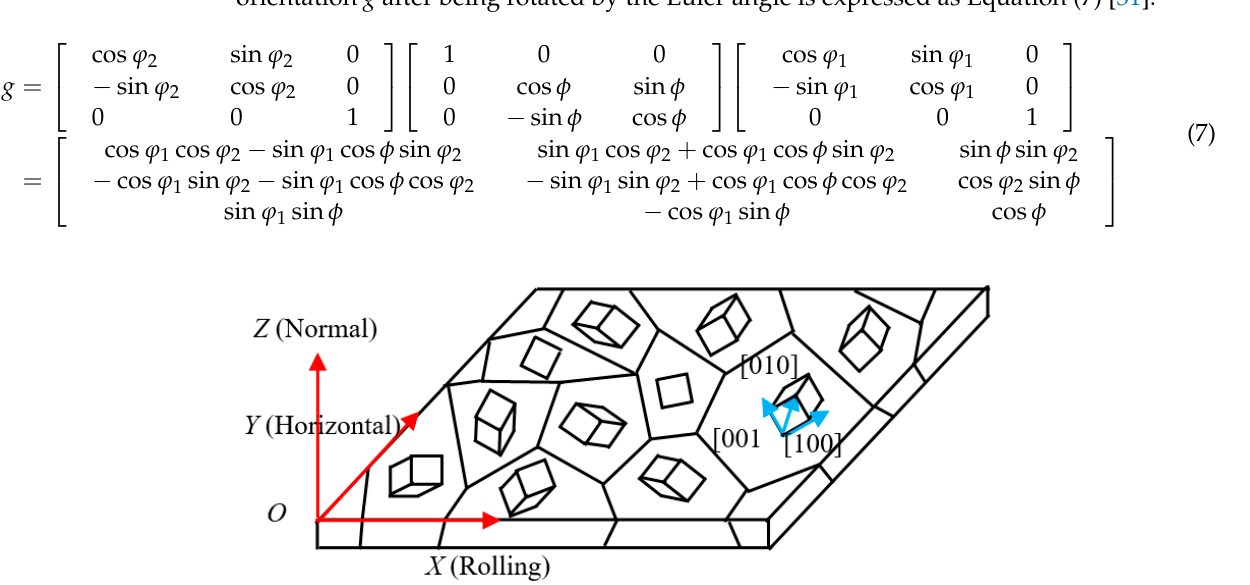
orientation g after being rotated by the Euler angle is expressed as Equation (7) [31]: